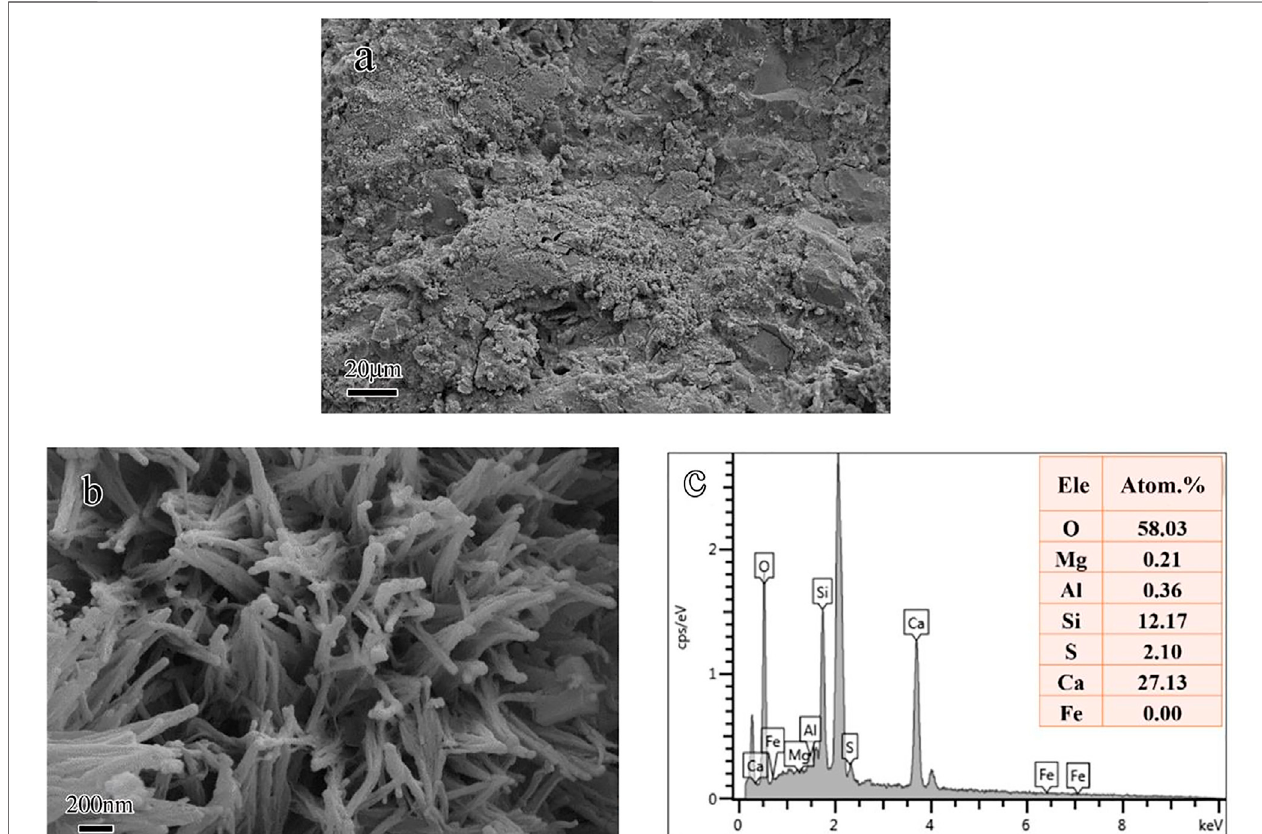
Frontiers in Materials |